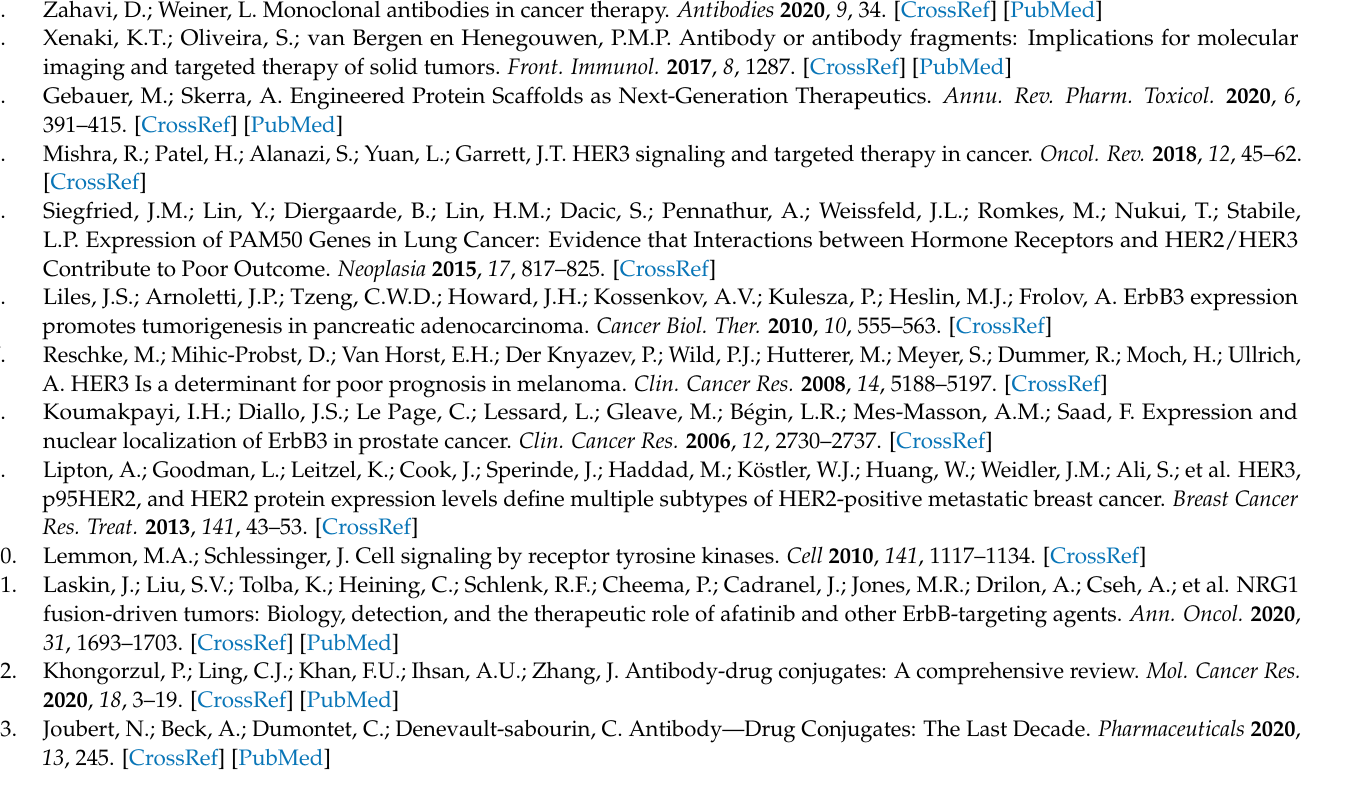
pi; Table S2: Biodistribution of [ 99m Tc]Tc-(HE) 3 -Z HER3 in BxPC-3 xenograft bearing mice at 1 h pi; Table S3: Biodistribution of [ 99m Tc]Tc-Z HER3 -ABD-mcDM1 and [ 99m Tc]Tc-Z HER3 -ABD-AA in DU145 xenograft bearing mice at 24 h